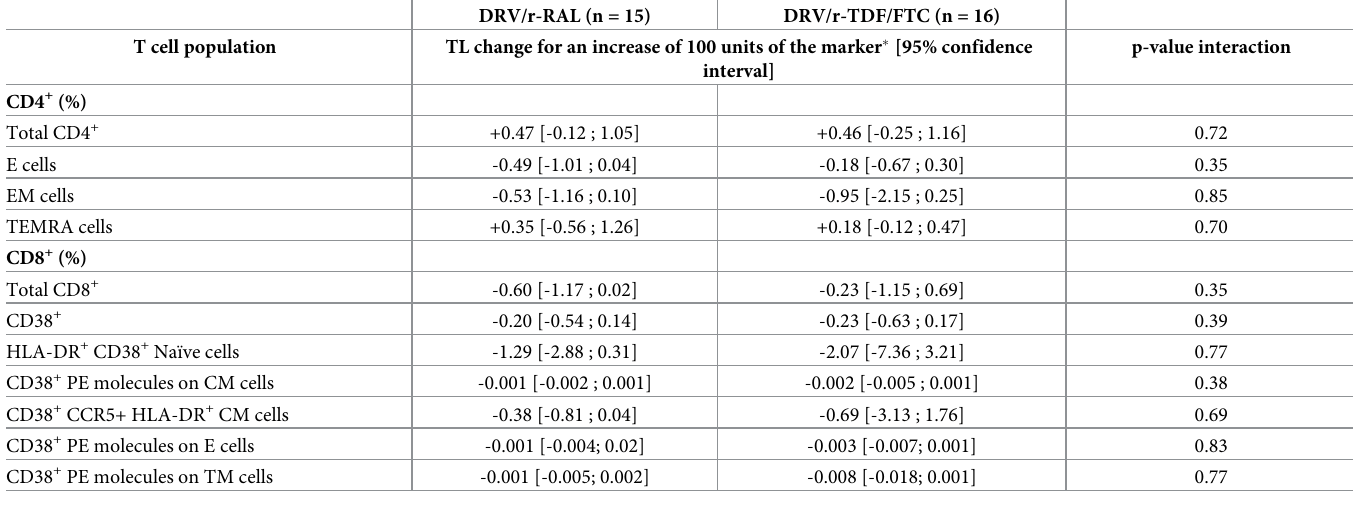
Table 2. Correlation between change of the CD4 and CD8 population markers and change in telomere length between W00 and W96 according to treatment group, n = 31. DRV/r-RAL (n = 15) T cell population TL change for an increase of 100 units of the marker � [95% confidence